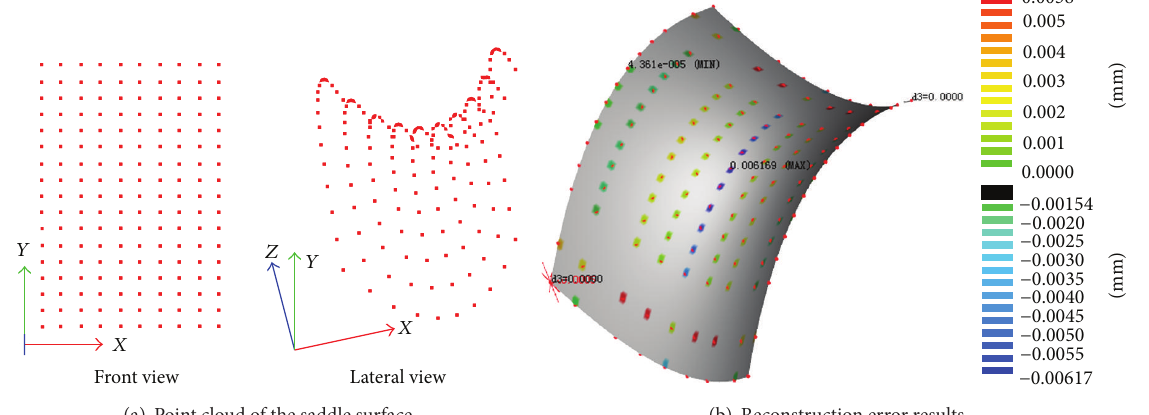
Figure 10: Reconstruction algorithm verification.